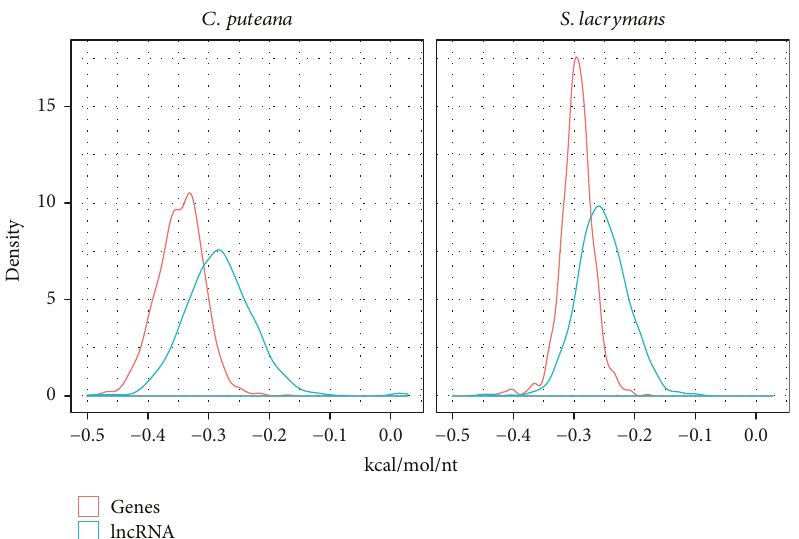
Figure 4: Minimum free energy (kcal/mol/nt) of 1,000 random lncRNAs and coding transcripts normalized by length.